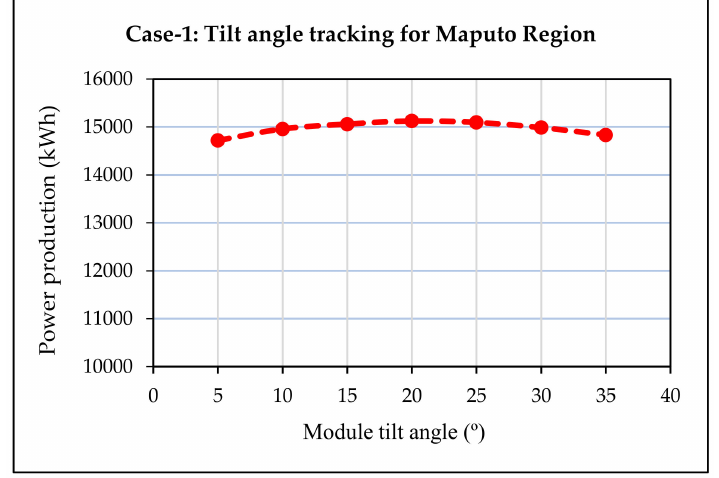
Figure 11. The power output system for distinct tilt